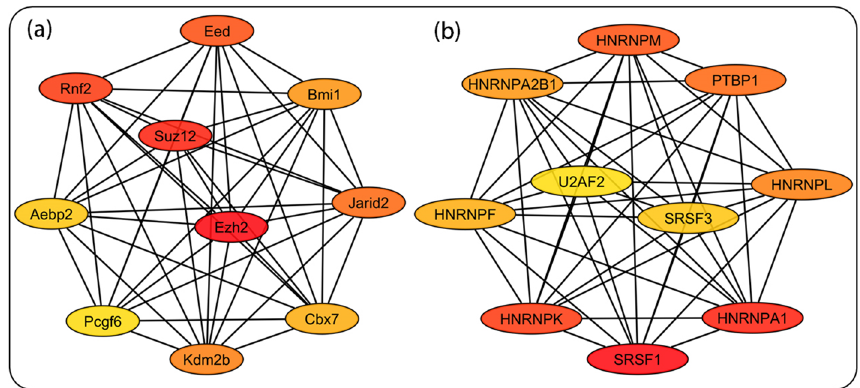
Fig. 3 Hub proteins of tran- scriptional regulator (TRs) and RNA-binding protein (RBPs) networks. The top ten hub proteins of the TR ( a ) and RBP ( b ) networks having extensive interconnections are